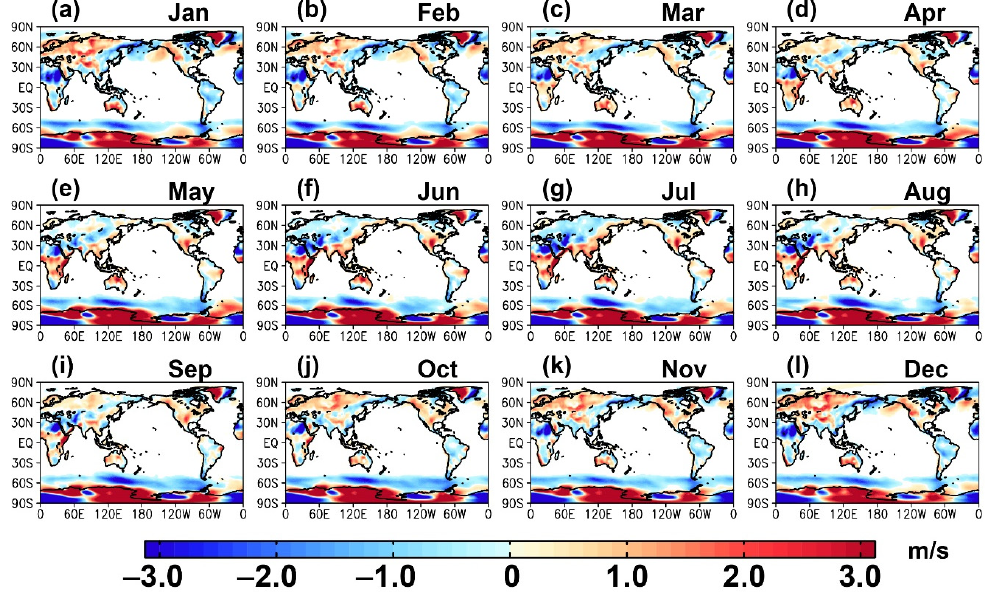
Figure 15. Global distribution of the FBGMW at 1000 hPa derived from M1 using the MRM data sets (1979–2018). ( a – l ) The FBGMW from January to December. The units for the FBGMW are m/s.